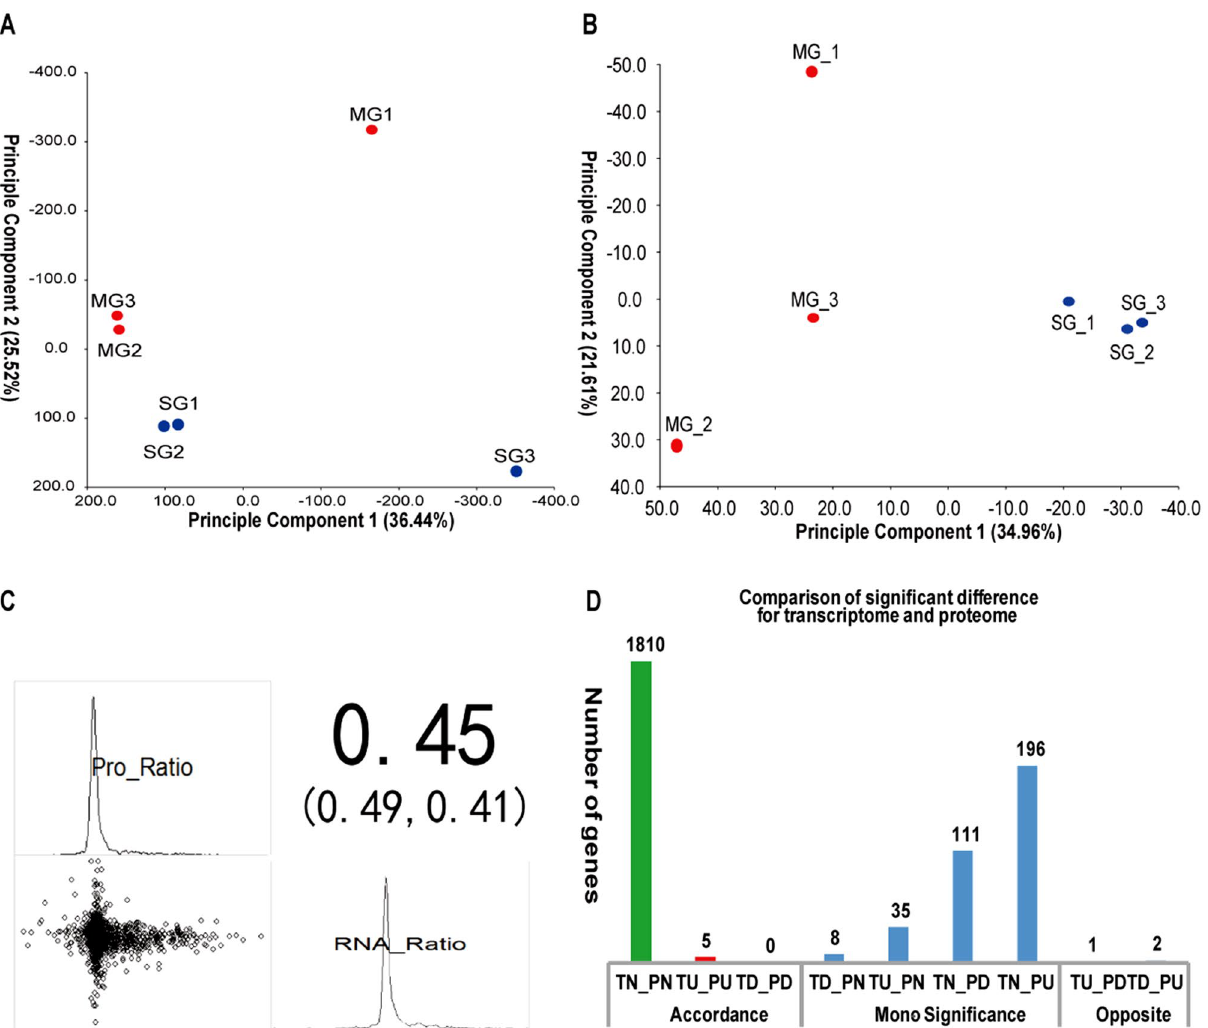
Figure 1. ( A ) Principal component analysis at the transcriptome level. SG-gene represents genes of NIL-723, MG-gene represents genes of NIL-1010, SG-protein represents proteins of NIL-723, MG-protein represents proteins of NIL-1010. ( B ) Principal component analysis at the proteome level. ( C ) The correlation analysis of abundance changes from transcriptome to proteome. Expression values were normalized by z-scoring, and the Pearson correlation coefficient was calculated for all genes with corresponding proteins identified in 723 and1010. ( D ) Comparison of significant differences between the transcriptome and proteome. T: transcript; P: protein species; N: no change; U: up-regulation; D: down-regulation. Accordance represents a consistent changing trend between the transcriptome and proteome; Mono significance represents mono-significant differences between the transcriptome and proteome; opposite represents that the transcriptome and proteome have opposite changing trends. plot generated using the ‘ggplot2’ packages in R 31,32